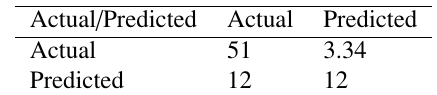
Table 2. CONFUSION MATRIX OF THE PROPOSED